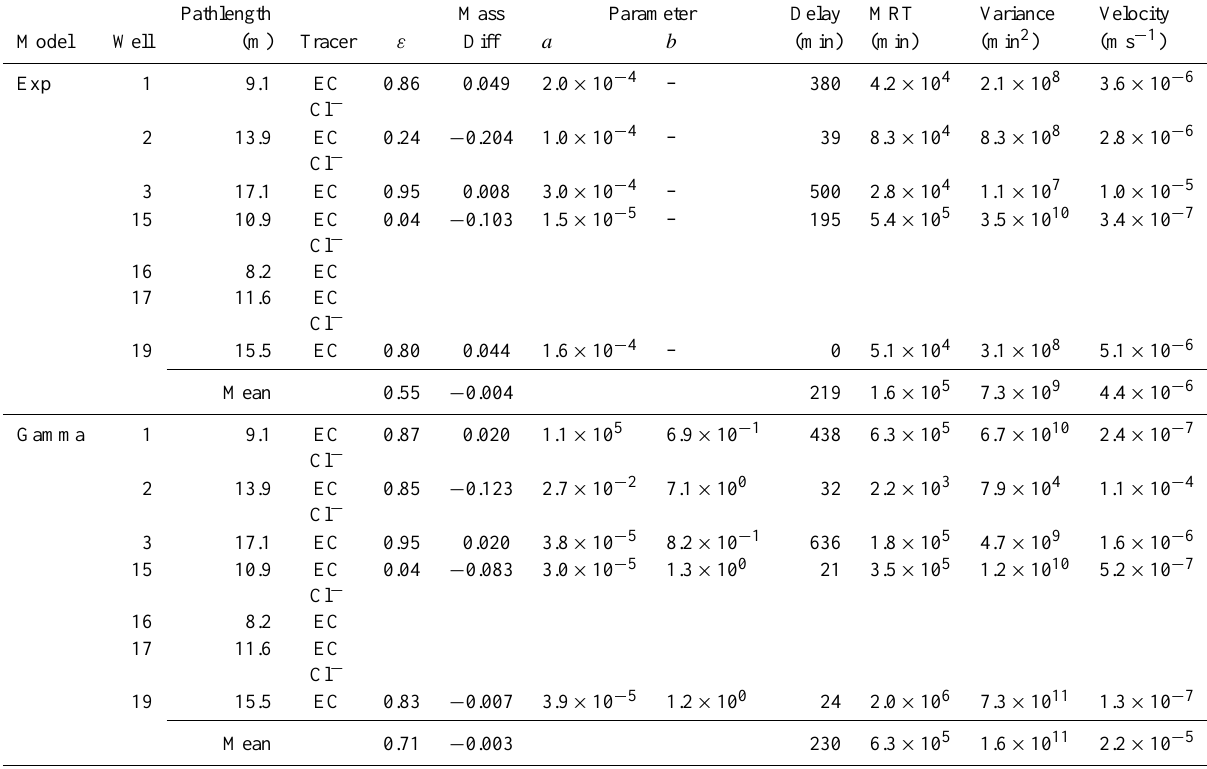
Table 4. Modeling results of tracer transport for no-salt test. Negative values of Mass Diff (proportional mass difference) indicate greater mass in the model than in the observations. Dashes indicate parameters that were not modeled for a specific well. Individual well–tracer combinations that were not modeled are included in the table as blank